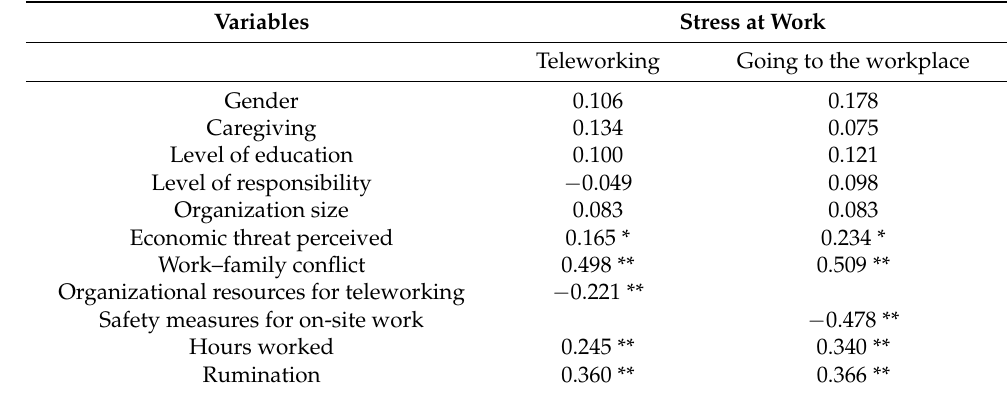
Table 2. Correlations between work-related stress and extra-organizational, organizational, and individual variables according to work modality.